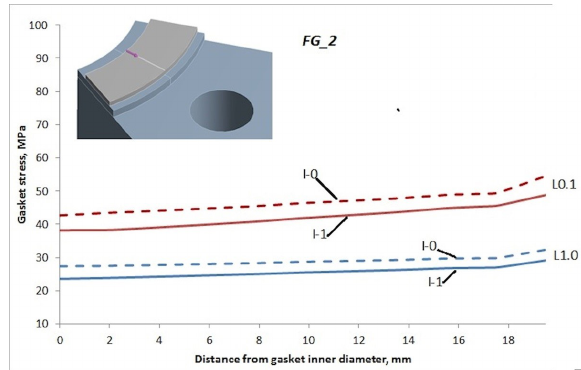
Figure 15: The radial contact stress along the gasket width in joint gasketed with FG_2 in all cases of loads